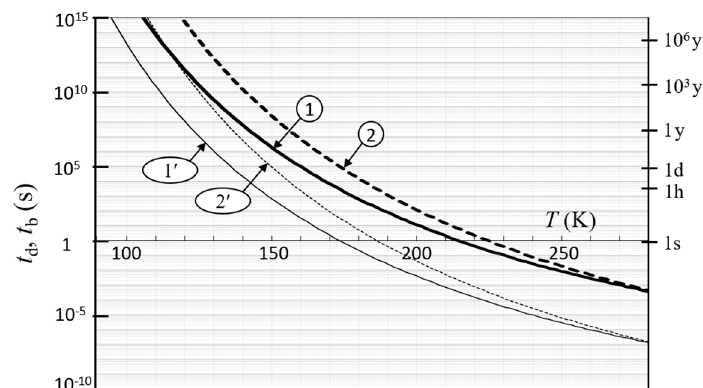
Figure 5. Calculated dissociation-beginning times (thin curves) and dissociation-completing times (thick curves) for a range of temperatures. The calculations assumed a basal extended dislocation with Burgers vector < a > with the larger-mobility value (solid curves) and smaller-mobility value (dashed curves) for Shockley partials. The dissociation-beginning time t b (curves 1 ′ and 2 ′ ) is the time needed to separate the two Shockley partials to a distance of 3 a . The dissociation-complete time t d (curves 1 and 2) is the time needed to separate the two Shockley partials to a distance of the equilibrium separation w e . Numerical data of t d and t b are in Table 2.